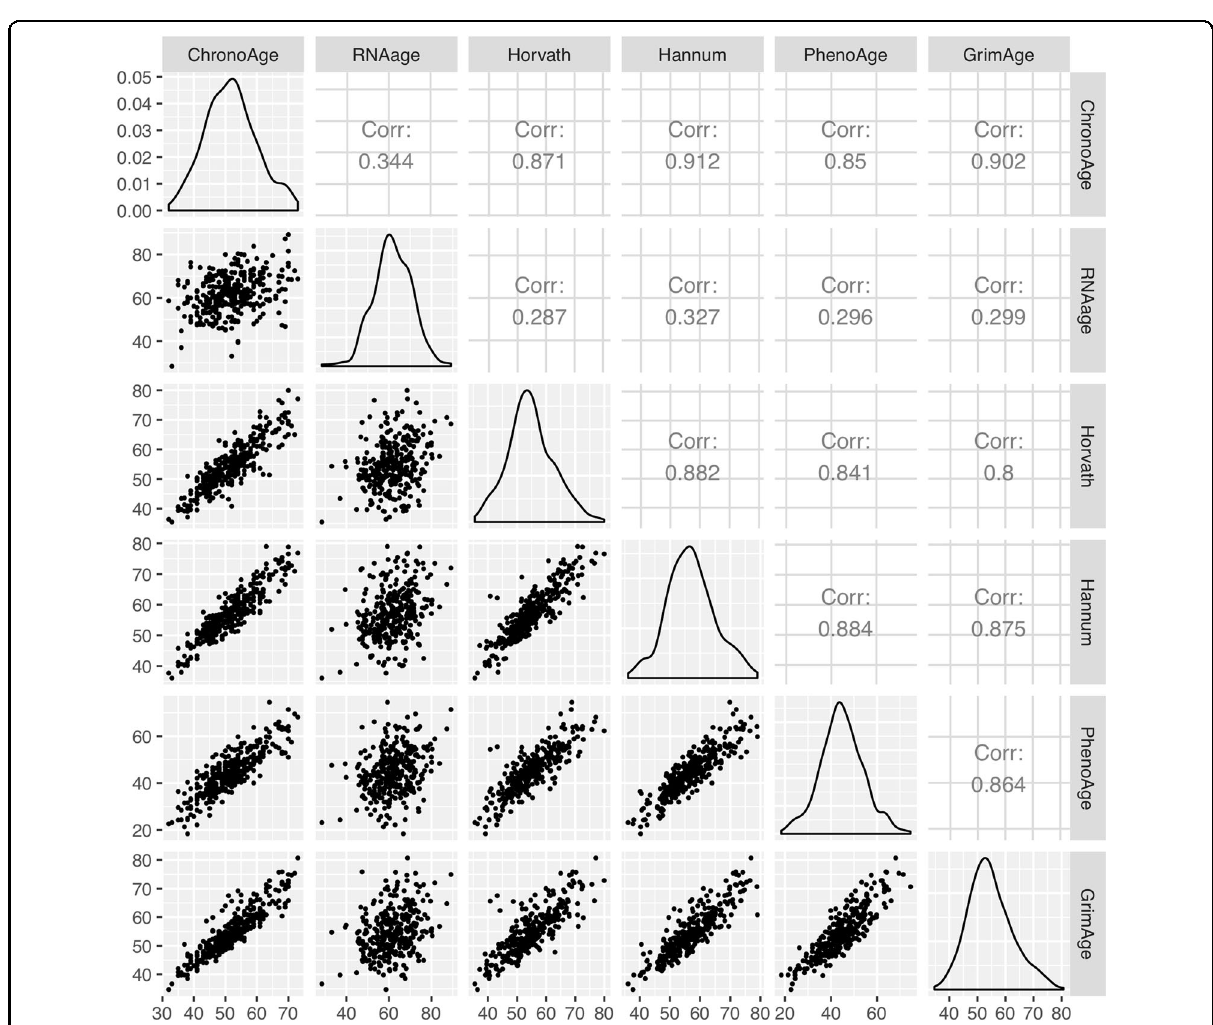
Fig. 1 Scatter plots comparing the four DNAm ages (Horvath, Hannum, PhenoAge, and GrimAge), transcriptional age and chronological age. The correlation coef fi cients between each pair is shown on the upper triangular matrix. All correlation coef fi cients were signi fi cant at p <